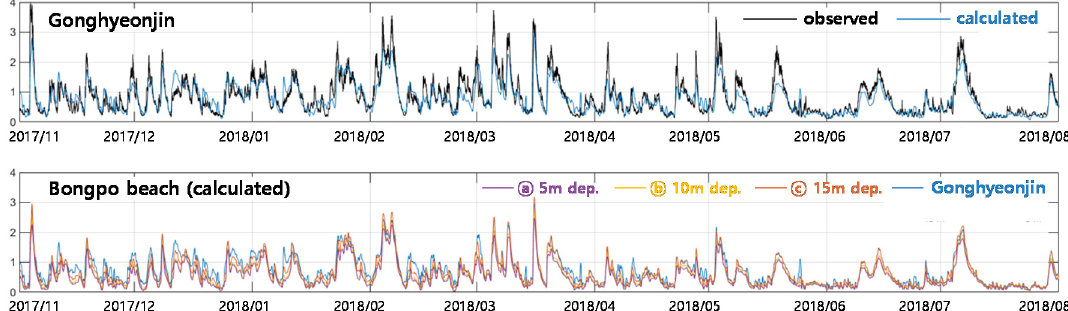
Figure 5. ( a ) Comparison of wave heights between the observed (black) and the calculated (blue) data at Gonghyeonjin Station, and ( b ) observed wave heights at Gonghyeonjin Station and modeled wave heights at 5, 10 and 15 m depths in Bongpo Beach, respectively. The blue lines denote the observed wave heights. The violet, yellow and orange lines denote the modeled wave height calculated at 5, 10 and 15 m depths, respectively (the locations of each depth are marked in Figure 1b).